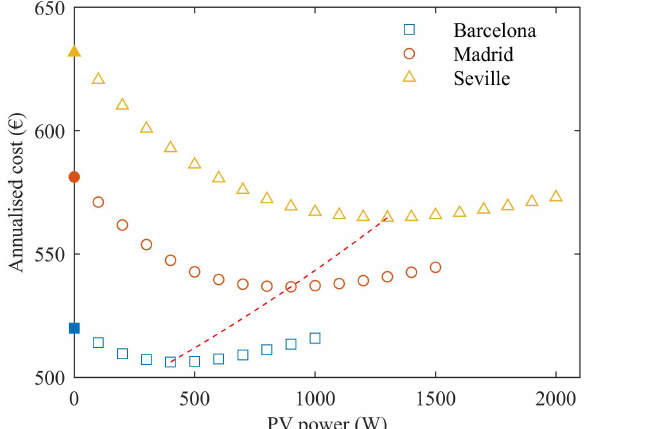
Figure 11. Results of the optimisation process for the different locations considered. The filled markers correspond to the values for the conventional system ( ˙ W PV = 0 W), and the dashed red line links the optimum values for the PV installed power in the locations